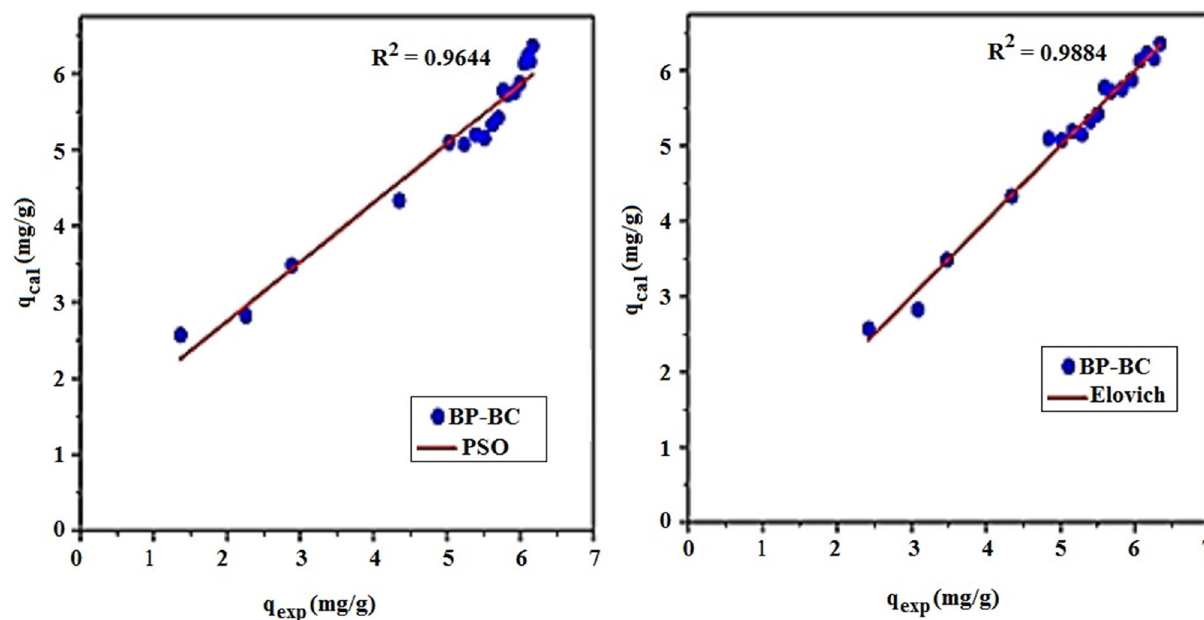
Figure 8. Influences data calculated by kinetic models on experimental